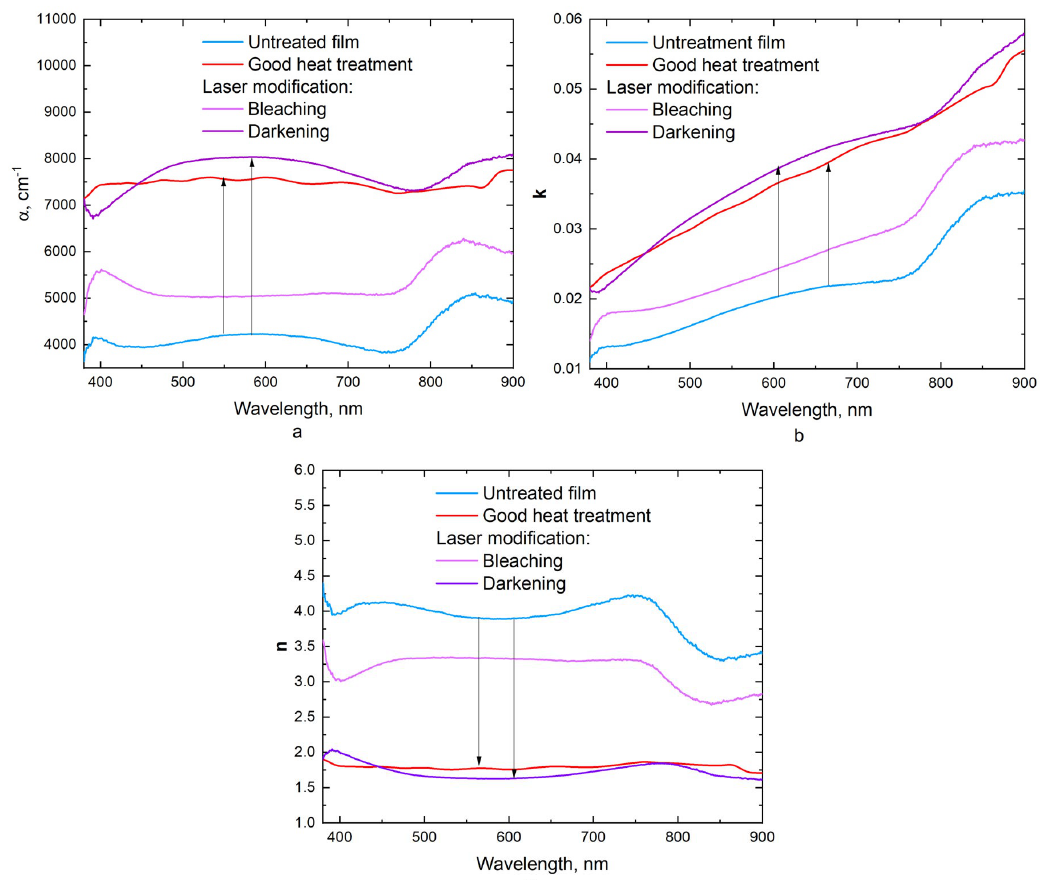
Figure 11. Optical characteristics of PbSe films for an untreated film (blue curve), a film after heat treatment (red curve), and a film after laser modification by pulsed radiation (pink and violet curves): ( a ) absorption coefficient α , ( b ) extinction coefficient k, ( c ) refractive index n.